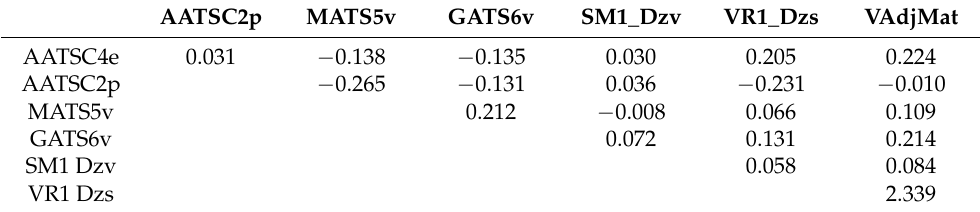
Table 2. The correlation coefficient matrix for the selected descriptors by